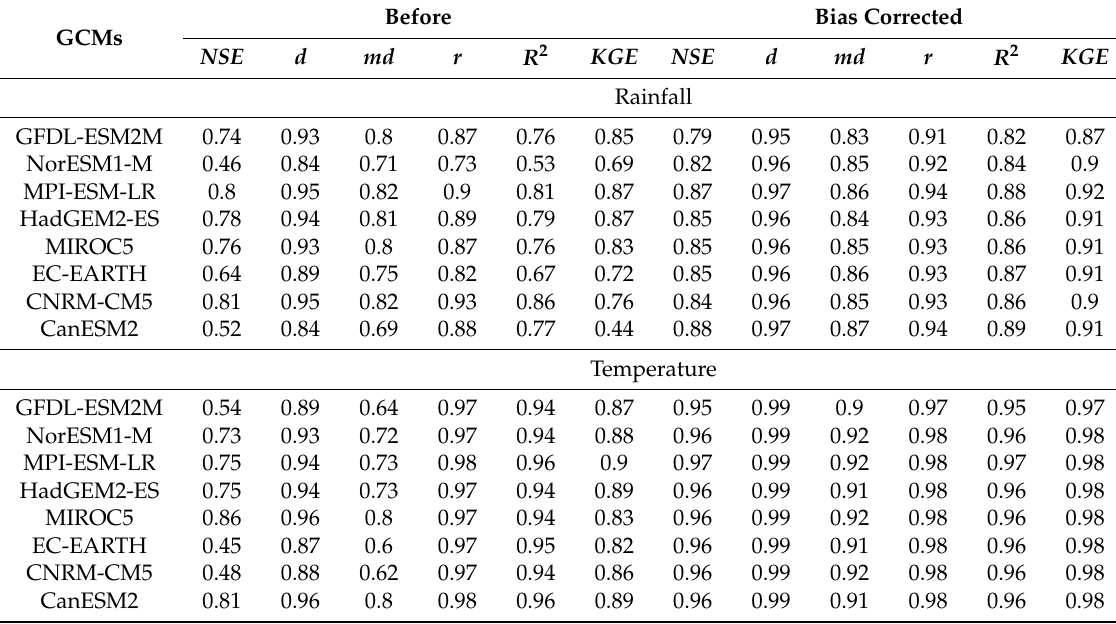
Table 3. Monthly efficiency coefficients of 8 GCMs compared to observations before and after bias correction. Nash-Sutcliffe Efficiency ( ∞ ≤ NSE ≤ 1) [52], Index